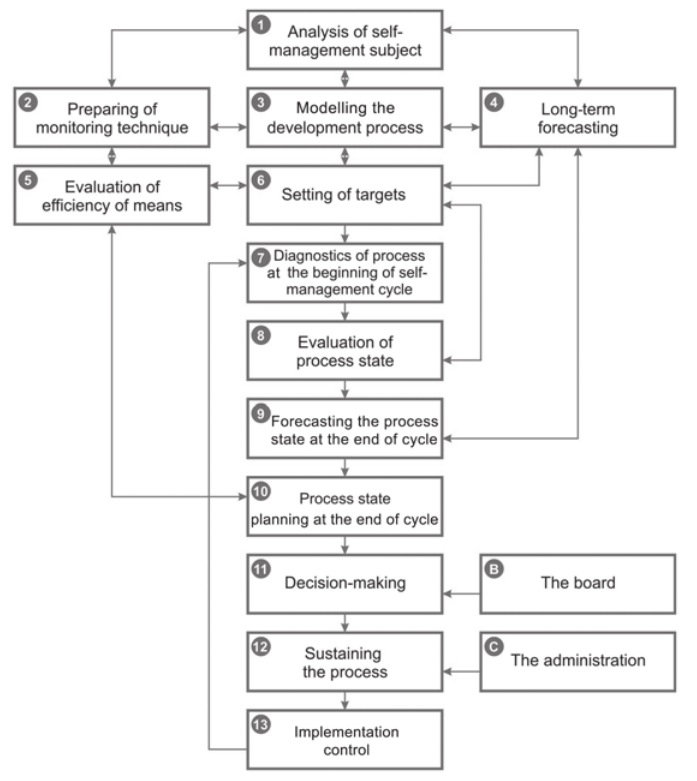
Fig. 4. The procedure of strategic